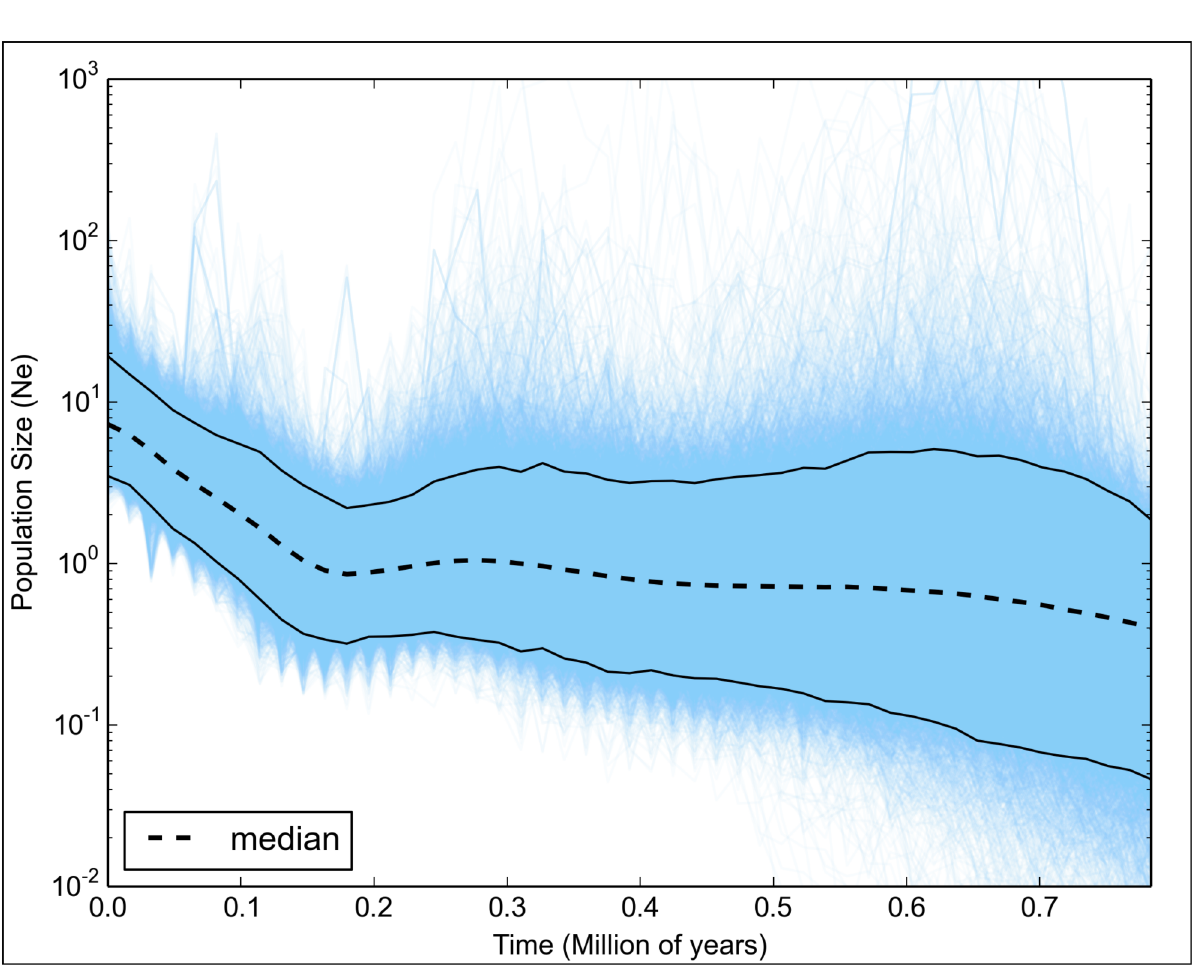
Fig 6. Population dynamics for L . purpureus taken from the Brazilian coast estimated by Bayesian Skygrid analysis. The x-axis shows time (in million years). The y-axis shows the product of the effective population size and generation time.